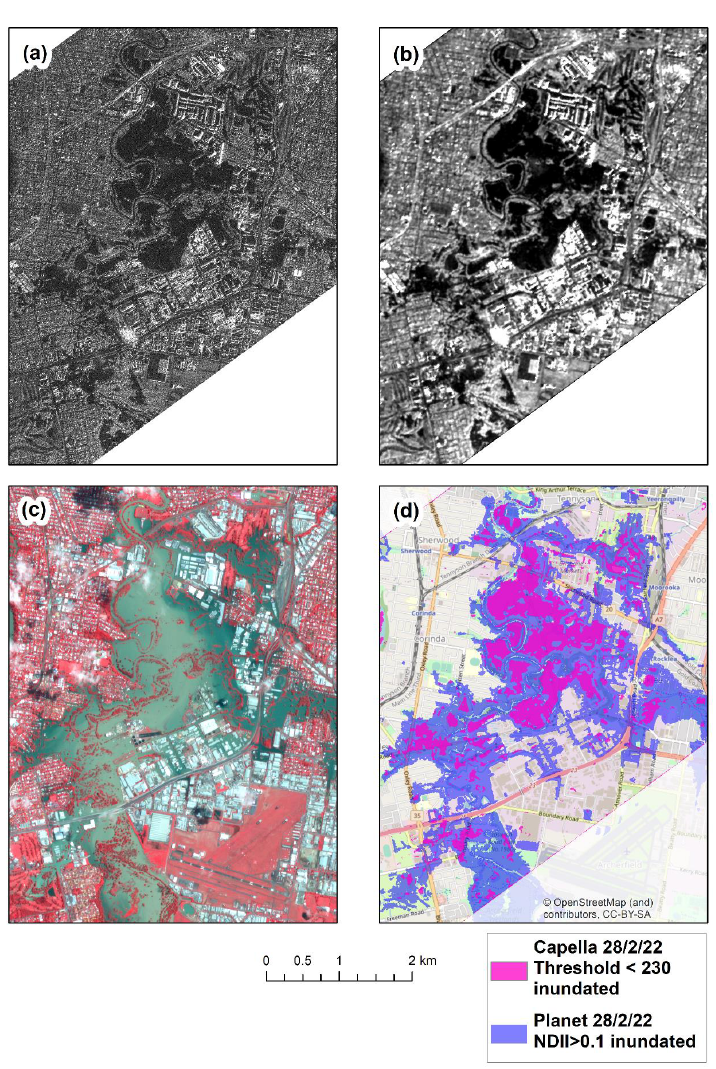
Figure 8. Comparison of inundated areas mapping from PlanetScope (based on change detection) and Capella (single image): ( a ) Capella image (28 February 2022) resampled to 3.2 m; ( b ) Capella image after running an adaptive box filter three times; ( c ) False color composite PlanetScope image, 28 February 2022; ( d ) Inundated areas derived from the PlanetScope and Capella images.